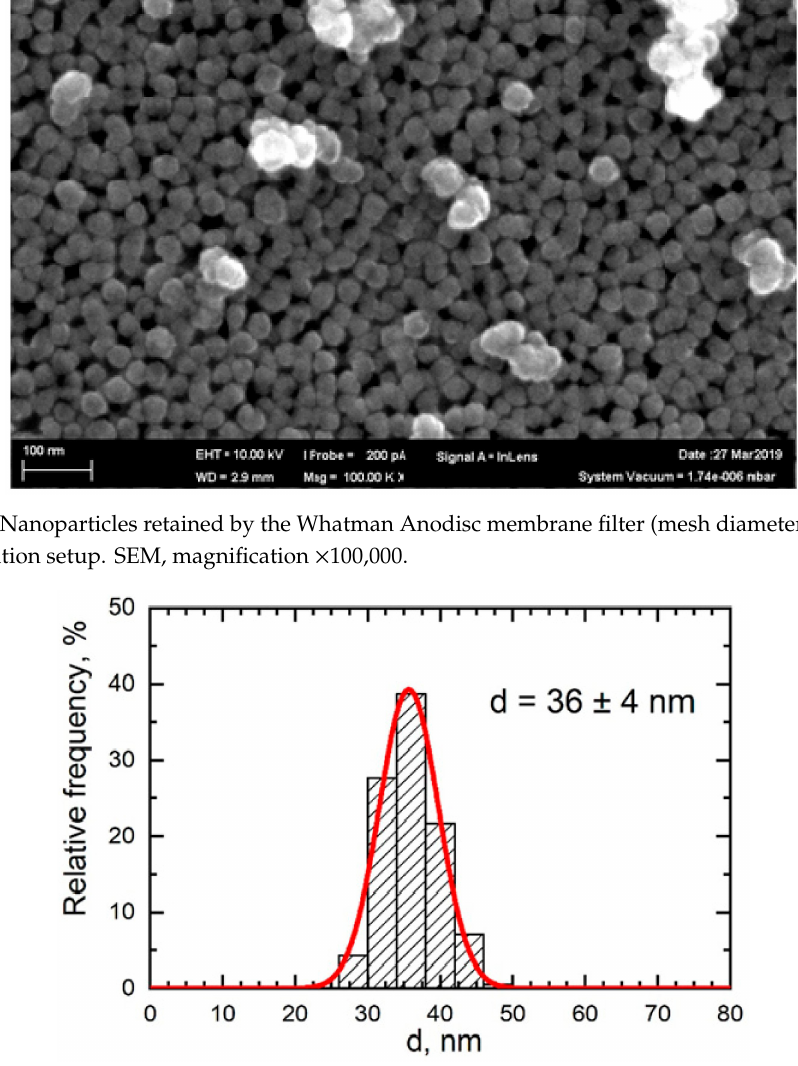
Figure 7. Particle or particle aggregate size normal distribution function (red curve) obtained by statistical processing of 360 measured SEM images of particles accumulated on a polycarbonate filter from the exposed rats’ breathing